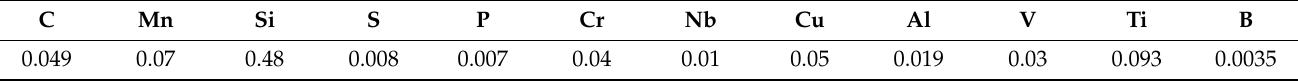
Table 4. Chemical composition (%) of the FLUXOFIL